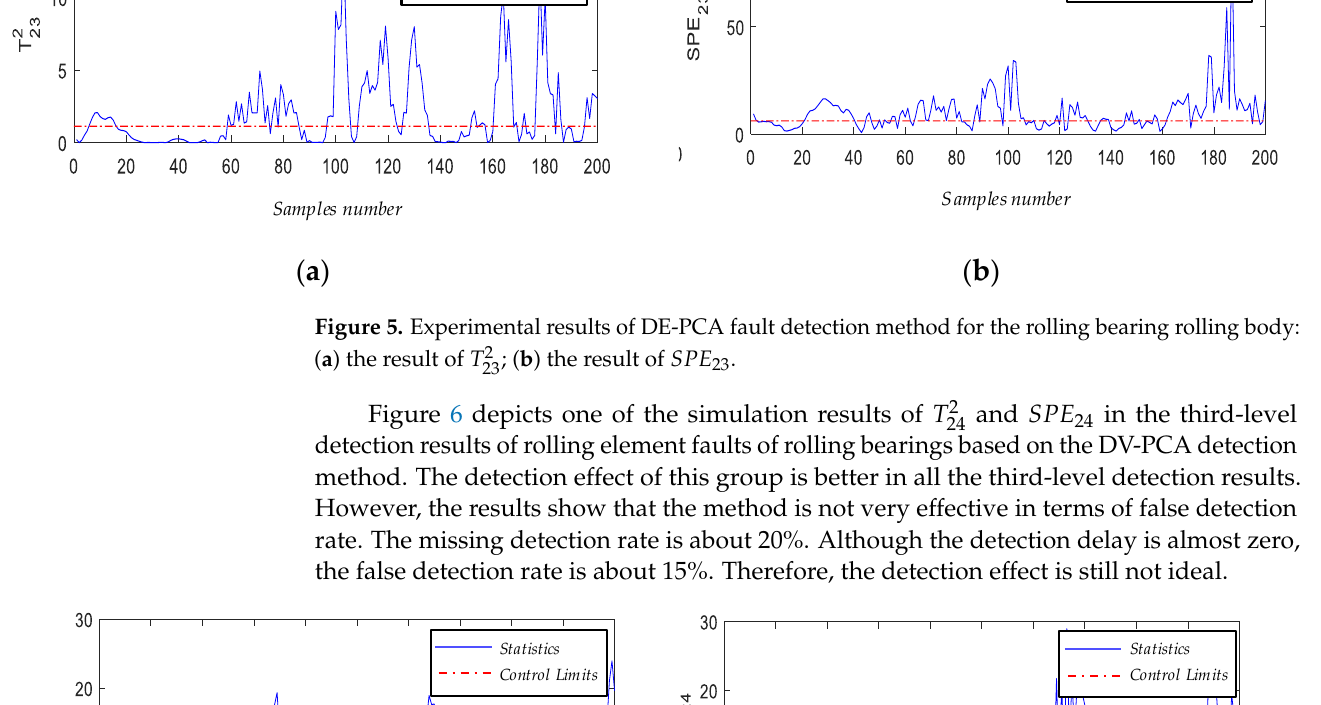
Figure 5. Experimental results of DE-PCA fault detection method for the rolling bearing rolling body: ( a ) the result of